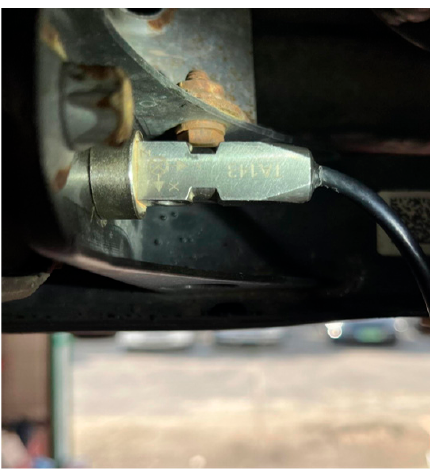
Figure 3. The location of the accelerometer on the bracket.